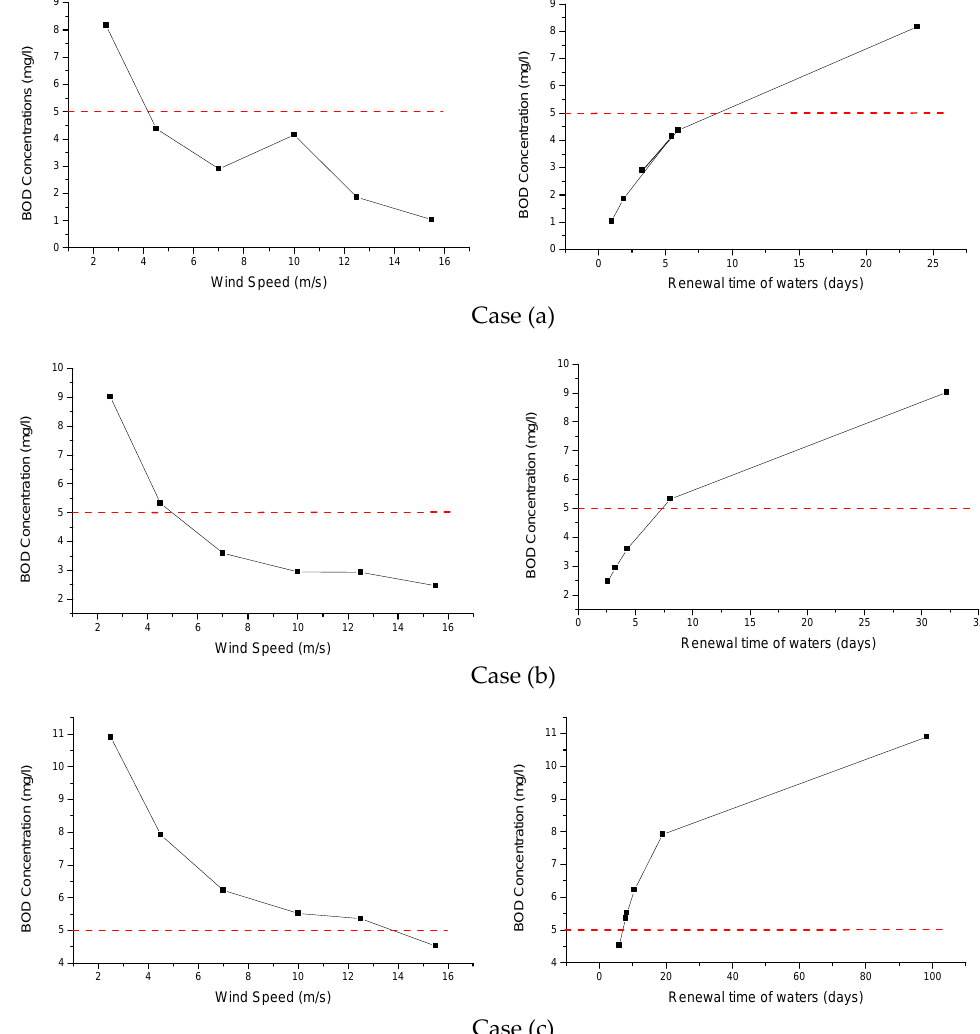
Figure 4. BOD for different values of wind speed and waters’ renewal time for the case of ( a ) a free opening, ( b ) a 50 m mole centred in the opening and ( c ) a 90 m mole centred in the opening.